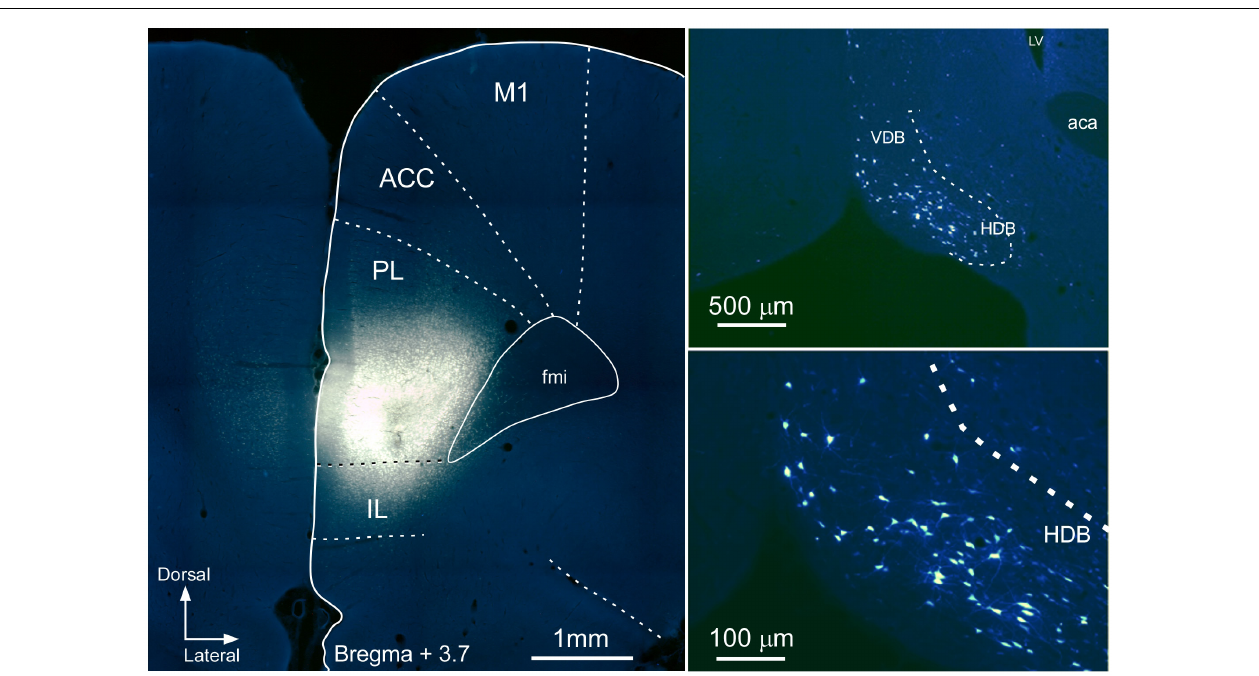
FIGURE 8 | Microphotograph of a coronal section at Bregma +3.72 mm showing the location of the FG injection in PL/IL cortices (Left) . Microphotographs at different magnifications of FG labeled neurons in HDB (Right) . ACC, anterior cingulate cortex; fmi, corpus callosum forceps; LV, lateral ventricle; M1, primary motor cortex; rest of lettering as in Figure 5